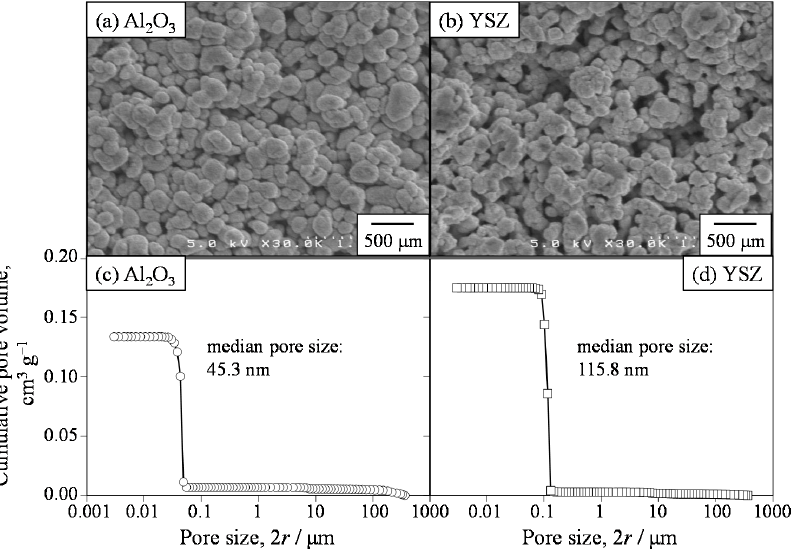
Figure 4. Microstructures ( a , b ) and pore size distributions ( c , d ) of Al 2 O 3 and yttria-stabilized zirconia (YSZ) porous ceramics by mercury porosimetry.